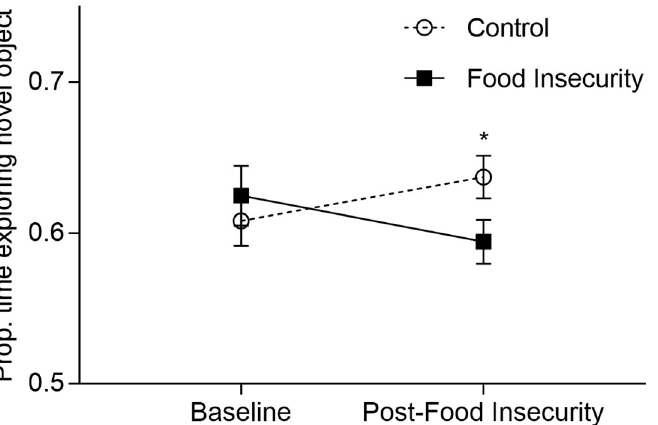
Fig 3. Effect of food insecurity on proportion of test time spent exploring novel object (mean +/-SEM). Mice were observed exploring unfamiliar objects before and after the food insecurity protocol. The proportion of time exploring the novel object increased among control mice ( Δ +2.9%) but decreased among mice exposed to food insecurity ( Δ -3.0%). (repeated measures two-way ANOVA, group x time interaction: F 1,62 = 4.55, P = 0.037). � P < 0.05.